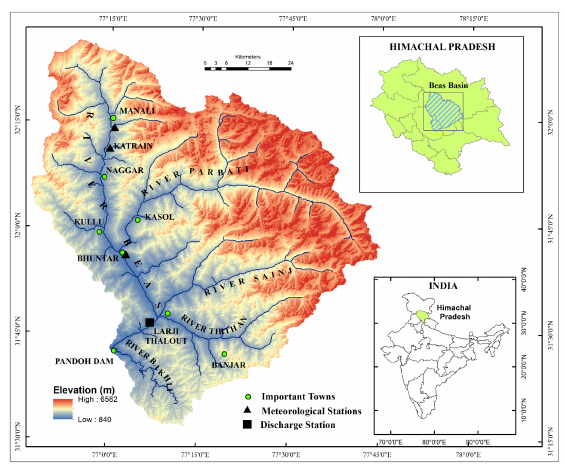
Figure 1. Location of upper Beas basin with elevation and meteorological